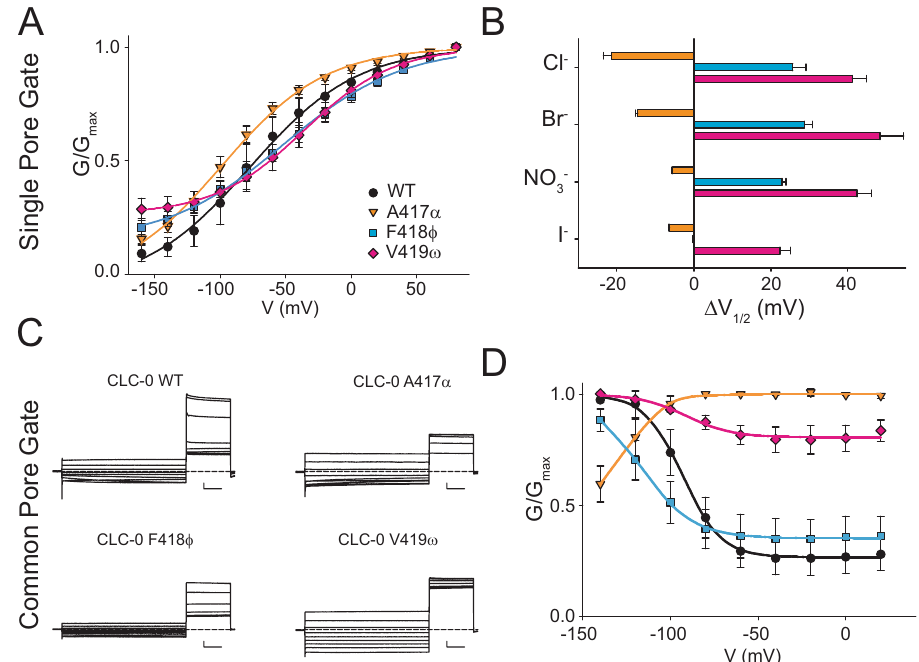
Fig. 3 | Pore-lining backbone amides affect fast and slow gating in CLC-0. A Normalized G – V curvesforfastgateofCLC-0WT(black),A417 α (orange),F418 φ (cyan)andV419 ω (pink)inCl − .Solidlinesare fi tstoEq.2.Valuesaremean±St.Dev. of n >7repeatsfrom N ≥ 3independentoocytebatches. B Δ V 1/2 =( V 1/2 mut − V 1/2 WT )of thenormalizedfastgate G – V ofWTandmutantCLC-0inCl − ,Br − ,NO 3 − andI − .Colors as in A . Errors represent the propagation of the uncertainty of the V 1/2 parameter